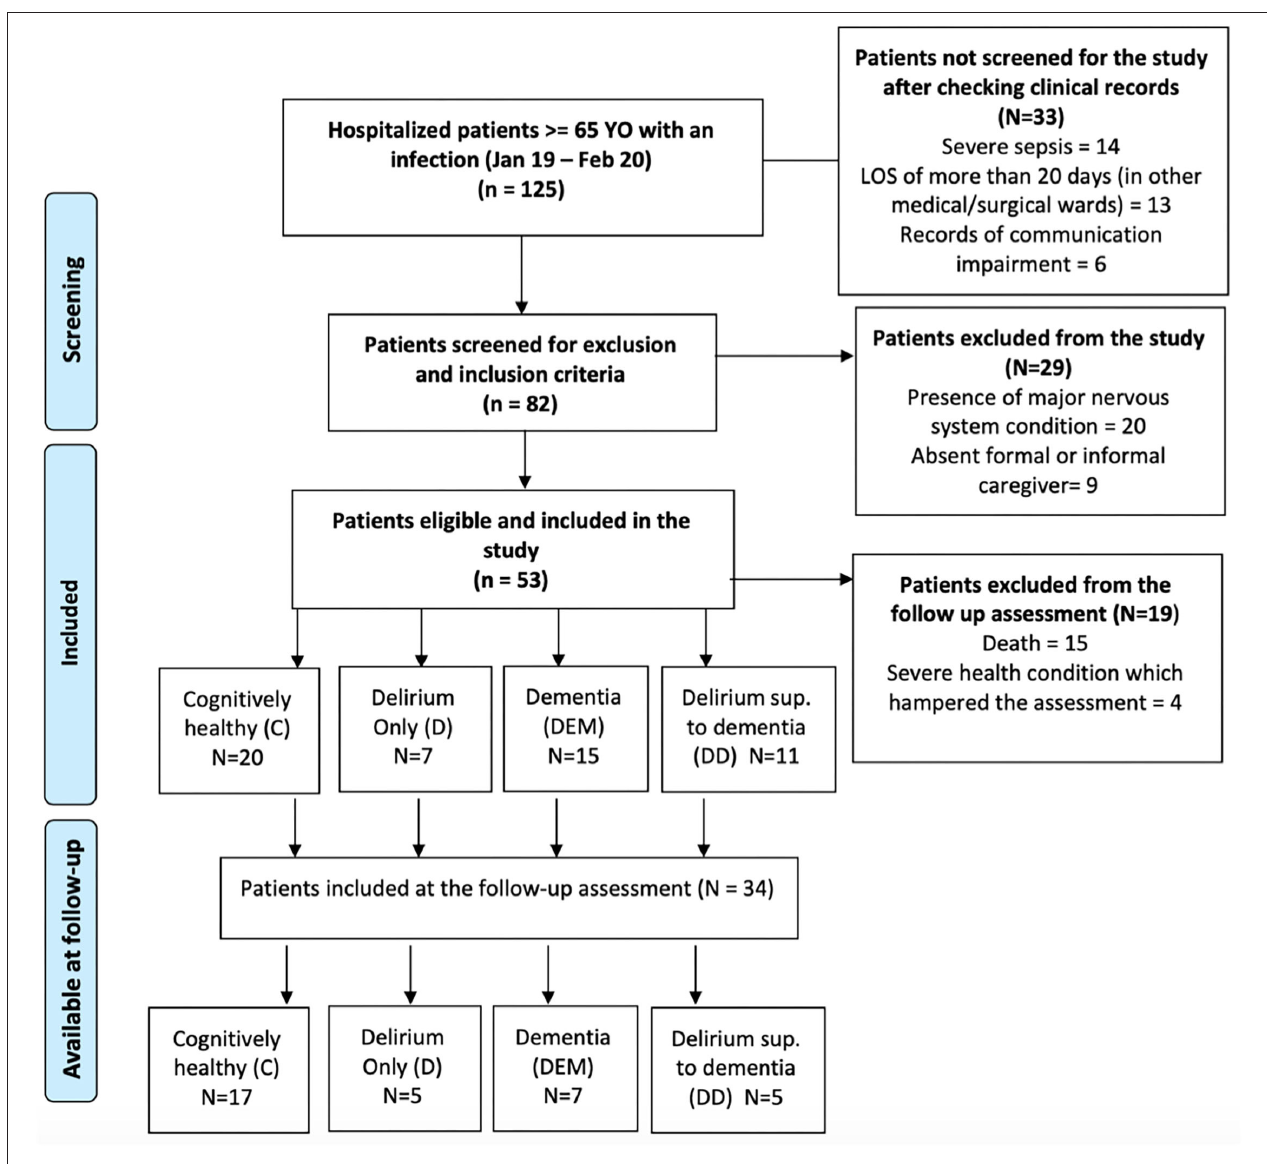
FIGURE 1 | Enrolment flowchart of the patients during hospitalization and at